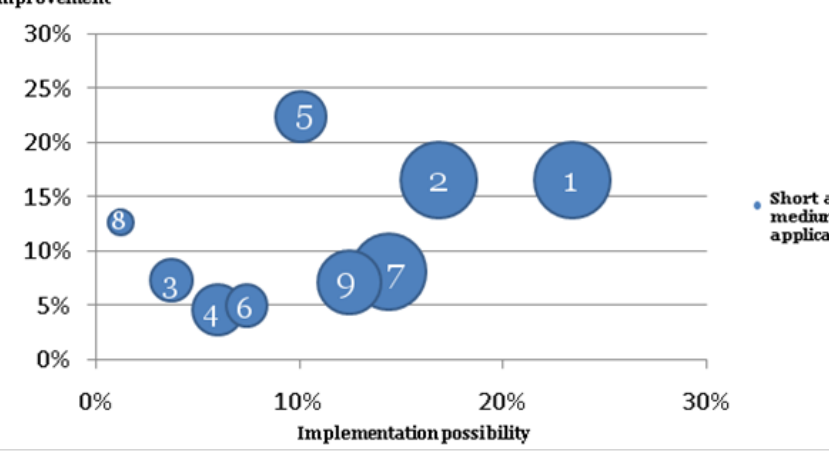
Figure 1. Results of the AHP